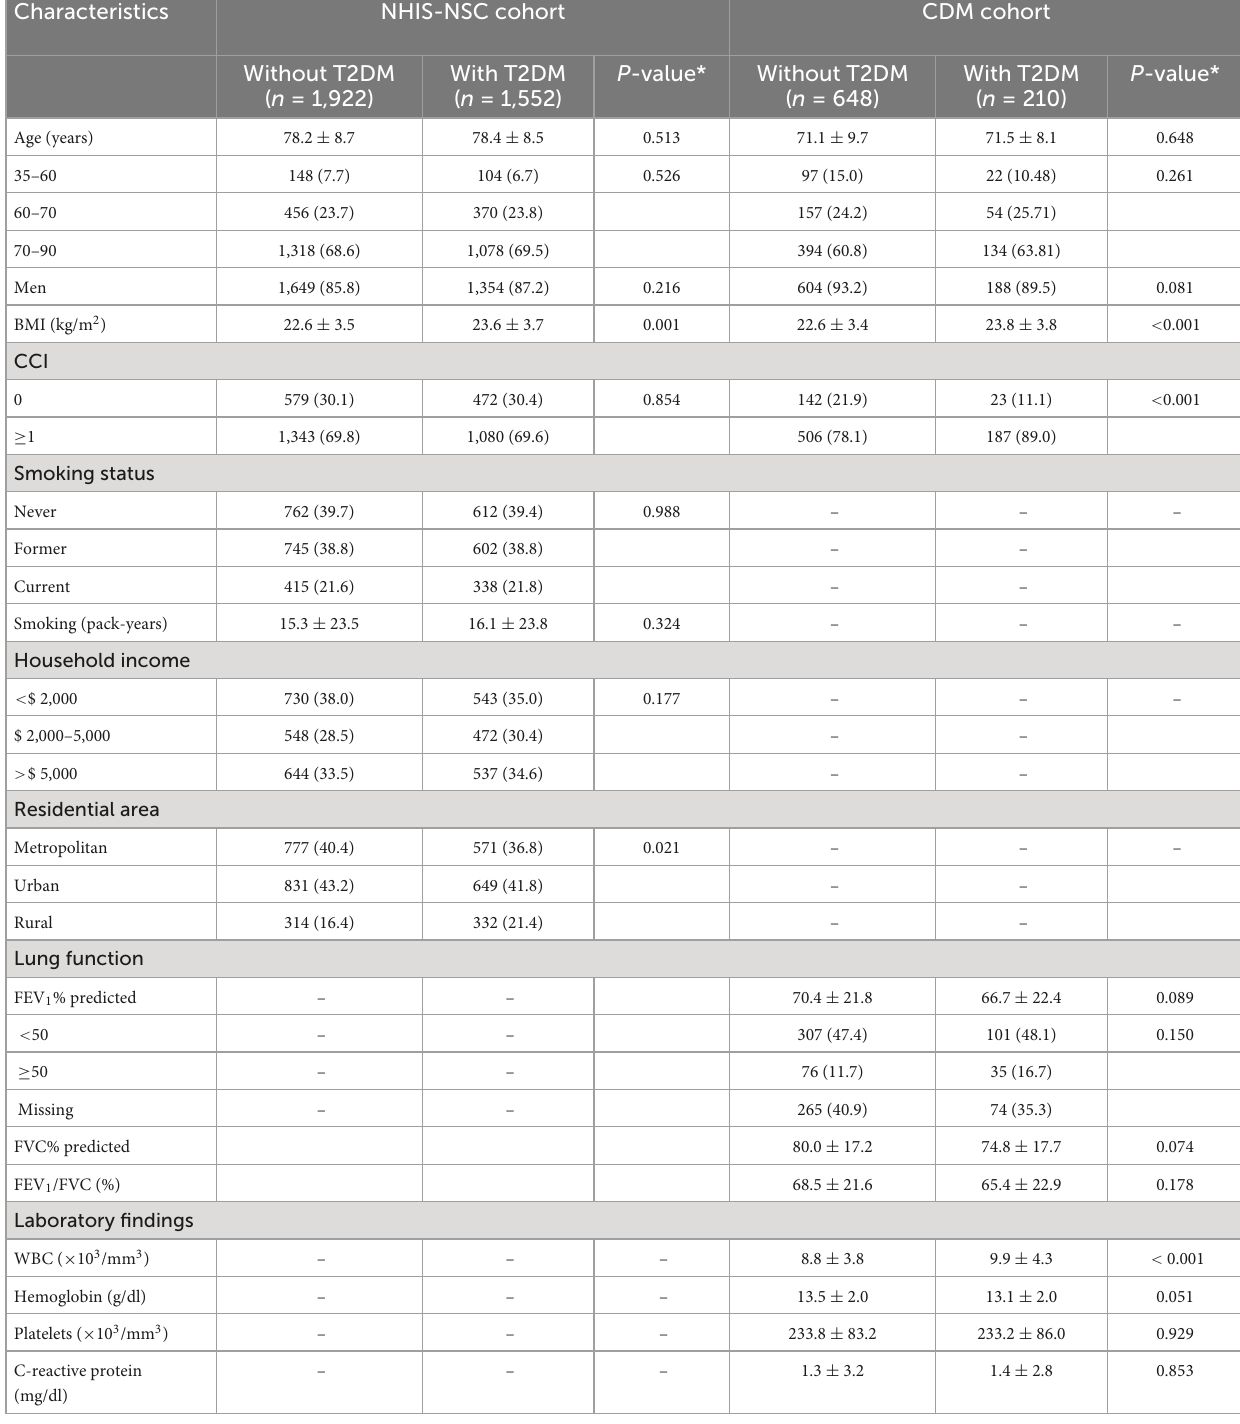
TABLE 1 Baseline characteristics of COPD patients with or without